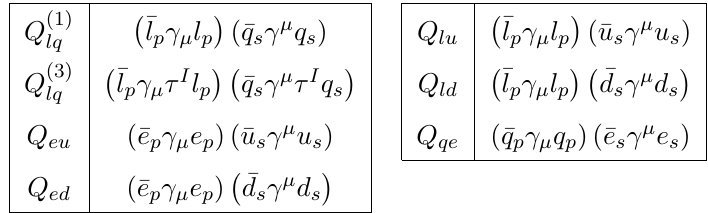
Table 1 . The baryon-number and CP-conserving operators contributing to dilepton production in the (cid:13)avor-symmetric limit at dimension six in the Warsaw basis [2] as four-fermion contact